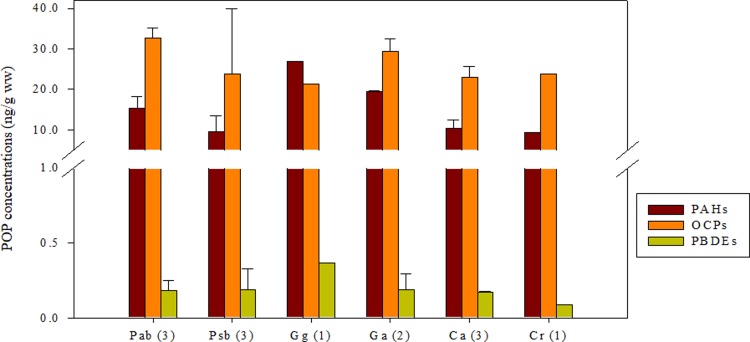
Concentration of Σ24PAH, Σ11OCP (A) and Σ17PBDE (B) among the six species of notothenioid fish.